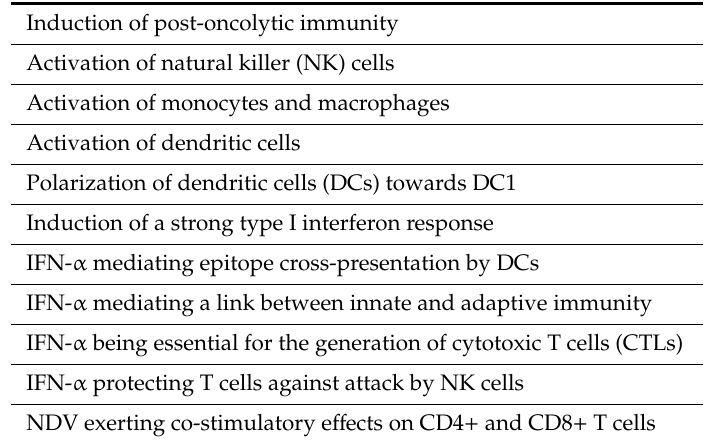
Table 1. Immune stimulatory e ff ects of Newcastle disease virus (NDV) in non-permissive